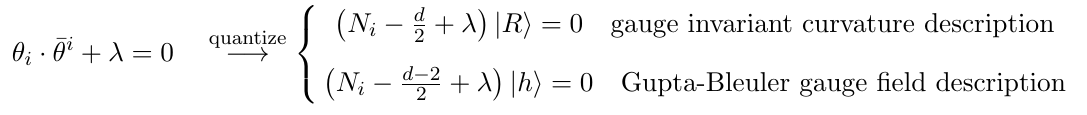
Gupta-Bleuler gauge (cid:12)eld